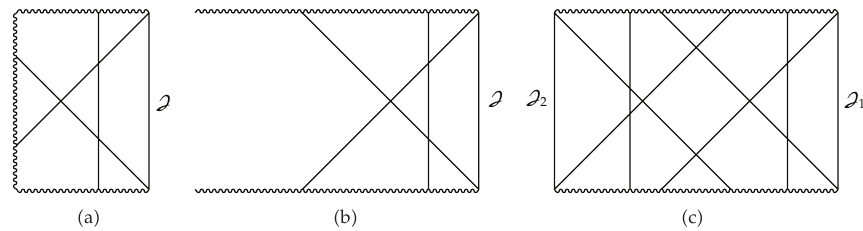
Figure 2: Penrose diagram for Λ < 0 and (cid:2) a (cid:5) λ > 0; (cid:2) b (cid:5) λ (cid:8) 0; (cid:2) c (cid:5) λ < 0, showing the matching surfaces and the